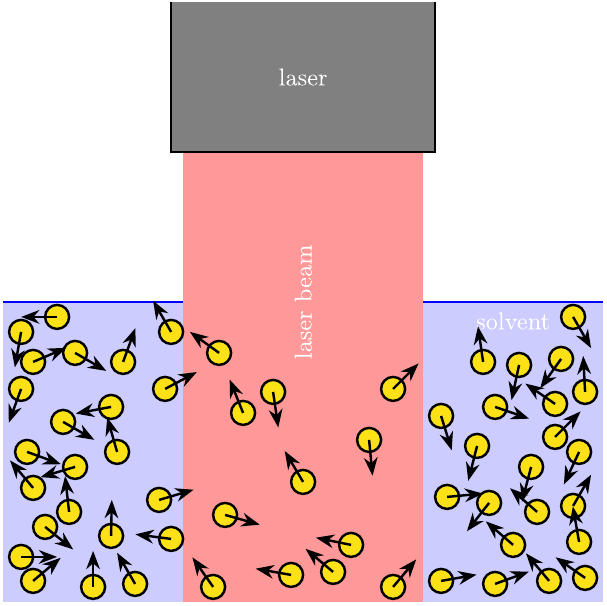
Fig. 3 | Possible experimental realization of the active tunnel effect. Active dielectricspheres(withorientationsindicatedbyarrows)areimmersedinasolvent and illuminated by a laser beam with rectangular intensity pro fi le. The intensity gradient at the boundaries of the beam gives rise to a force pushing the particles outwards.Duetoactivityandinteractions,thedensitydecayssmoothlyatthebeam boundaries, i.e., it is low also in the vicinity of the beam and not only in the illuminated